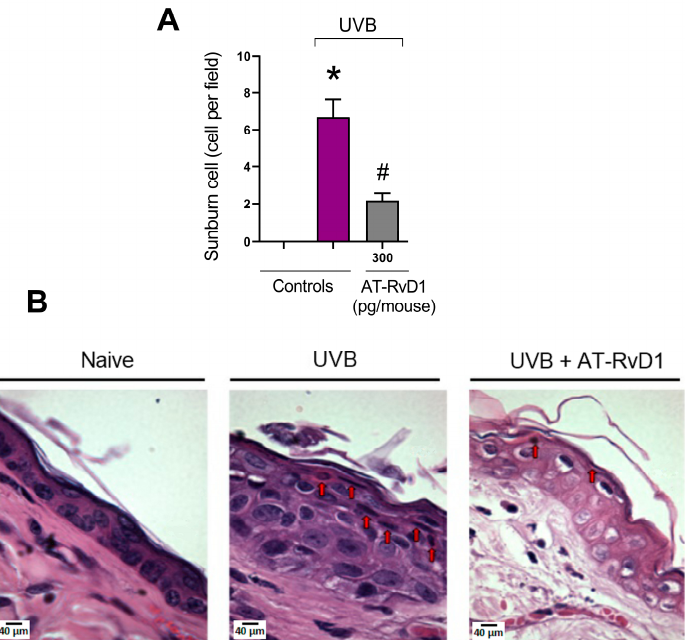
Figure 3. Effect of AT-RvD1 on the number of epidermal sunburn cells in hairless mice exposed to 4.14 J/cm 2 UVB radiation. The number of sunburn cells ( A ) and representative images of sunburn cells in the three tested groups—H&E stain ( B ). Skin samples were collected 12 h after the exposure. Arrows indicate examples of sunburn cells. Bars represent means ± SEM. Two separate experiments with five groups of 5 mice per group per experiment were performed. Statistical analysis was performed by one-way ANOVA, followed by Tukey’s post hoc test. * p < 0.05 compared to the nonradiated control group (orange bar); # p < 0.05 compared to the radiated control group (purple bar).